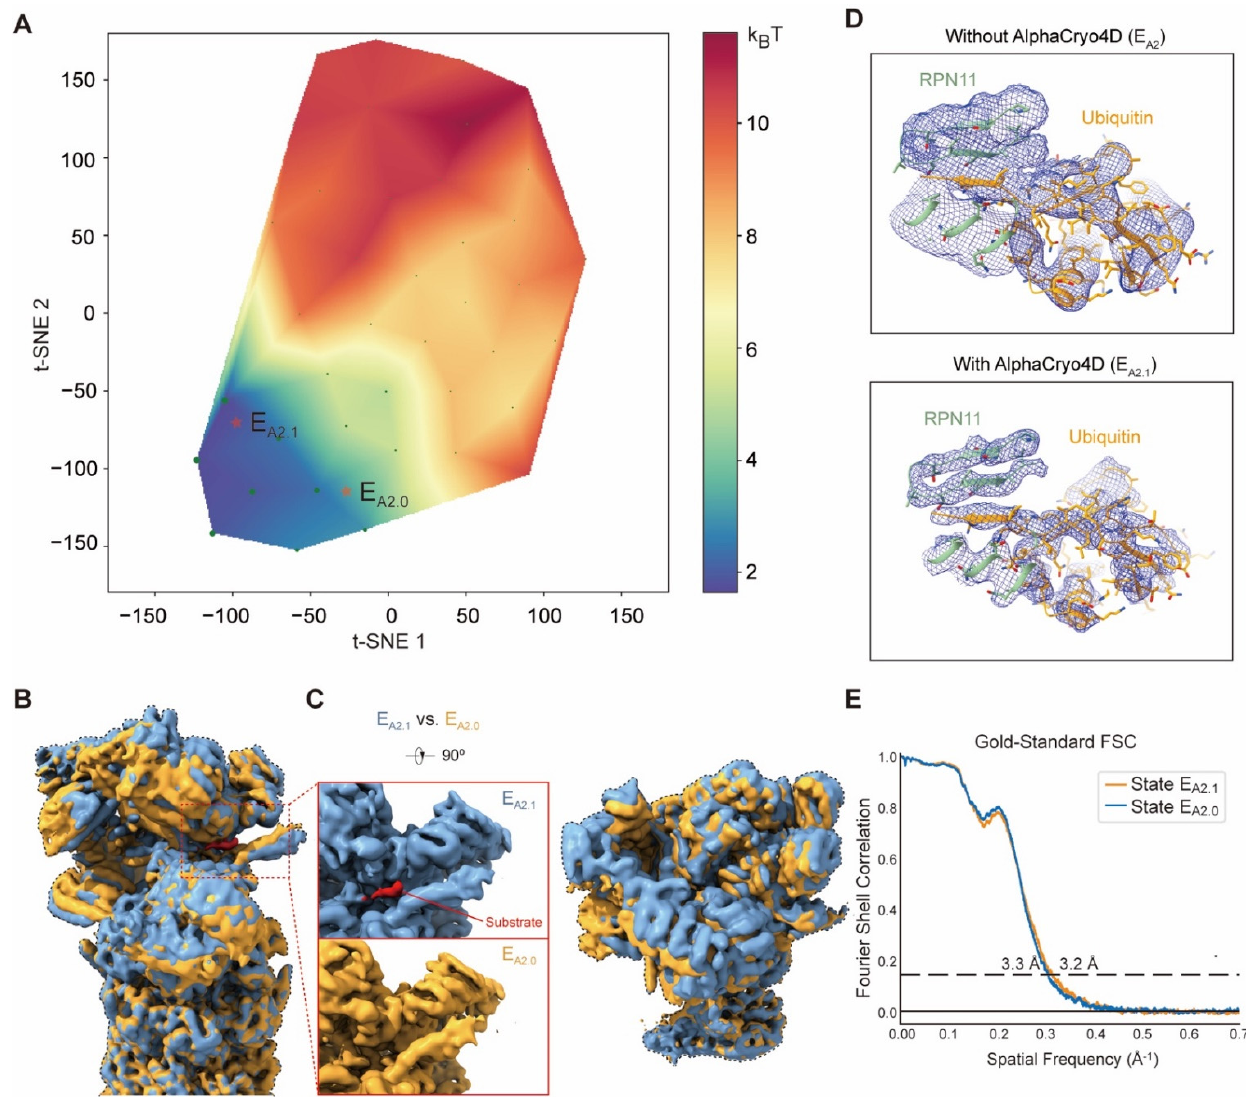
Figure 6. Resolution improvement of the dynamic components of the 26S proteasome by Al- phaCryo4D. ( A ) Pseudo-energy landscape calculated on the regulatory particle of the proteasome state E A2 . Clusters E A2 . 0 and E A2 . 1 were determined on this pseudo-energy landscape, revealing the states of substrate-unbound and substrate-bound RPN11, respectively. ( B , C ) Cryo-EM density map of cluster E A2 . 0 superimposed with that of cluster E A2 . 1 from two orthogonal viewing angles. Overall view, panel ( B ). Closeup view, panel ( C ). The lid subcomplex undergoes conformational changes during substrate binding. Insert of panel ( C ) shows a closeup side-by-side comparison of the two states. The red region denoted the substrate in the density map of the 26S proteasome (Supplemen- tary Video S1). ( D ) Quality and resolution improvement of local cryo-EM density map of the RPN11- bound 8.5-kDa ubiquitin in state E A2 . 1 (lower panel) relative to the previously published structure (upper panel) [25] . ( E ) Gold-standard FSC of states E A2 . 0 and E A2 . 1 of 26S proteasome reconstructed by AlphaCryo4D.